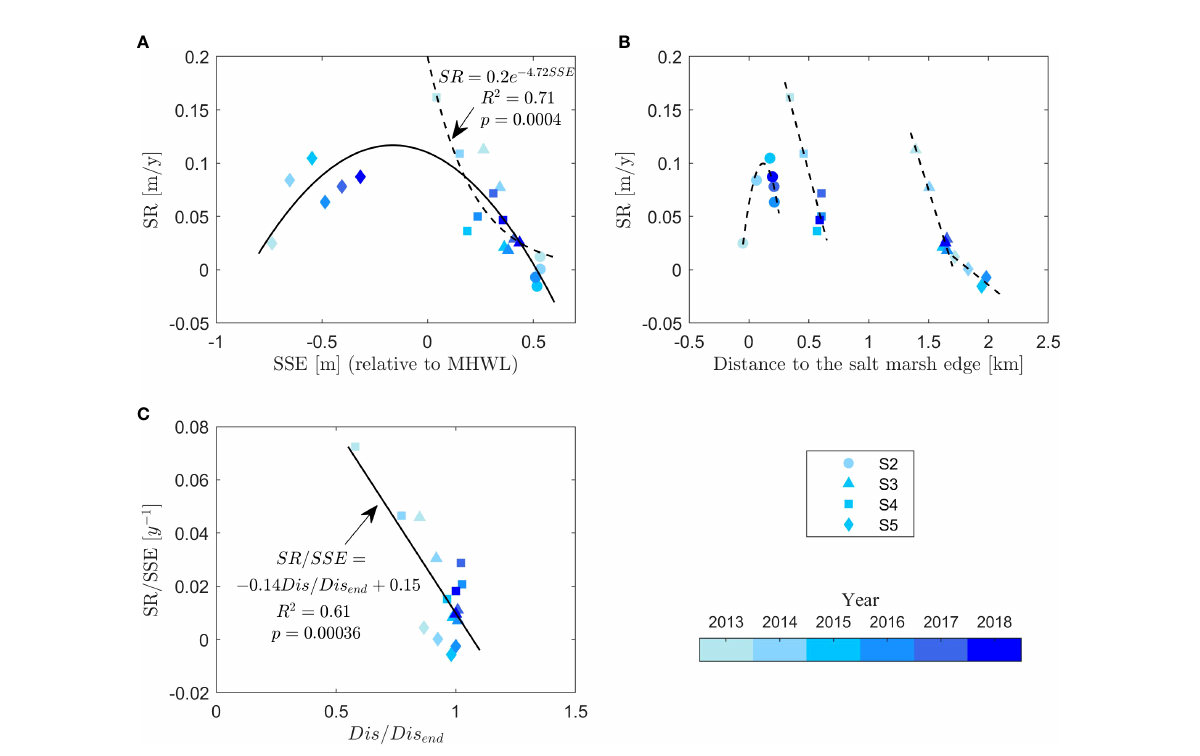
FIGURE 7 The yearly sedimentation rate as a function of (A) the relative soil surface elevation and (B) the distance from the salt marsh edge. (C) The normalized sedimentation rate by the soil surface elevation ( SSE ) as a function of the non-dimensionalized distance to the marsh edge ( Dis ) by the distance to the marsh edge in the year 2018 ( Dis end